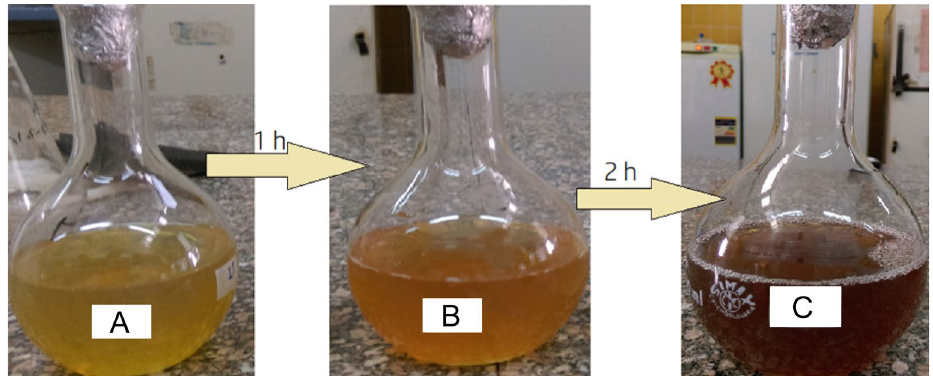
Figure 2. Color change during the bio-reduction of AgNO3 into AgNPs using C. sinuosa extract: ( A ) C. sinuosa extract before synthesis, ( B ) AgNO3 solution after adding C. sinuosa extract after one hour, ( C ) synthesized silver nanoparticles in dark brown colour solutions after two